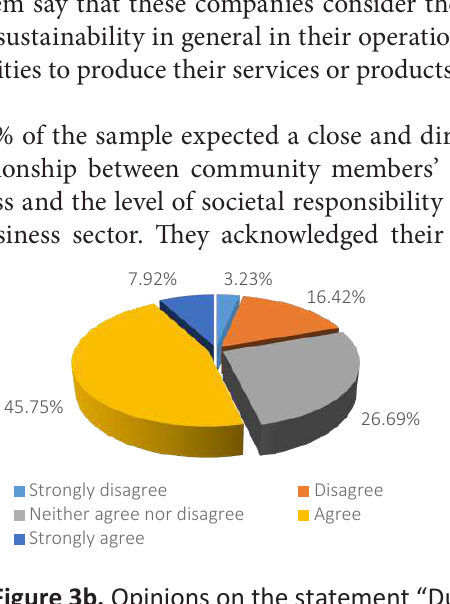
business firms contribute positively”